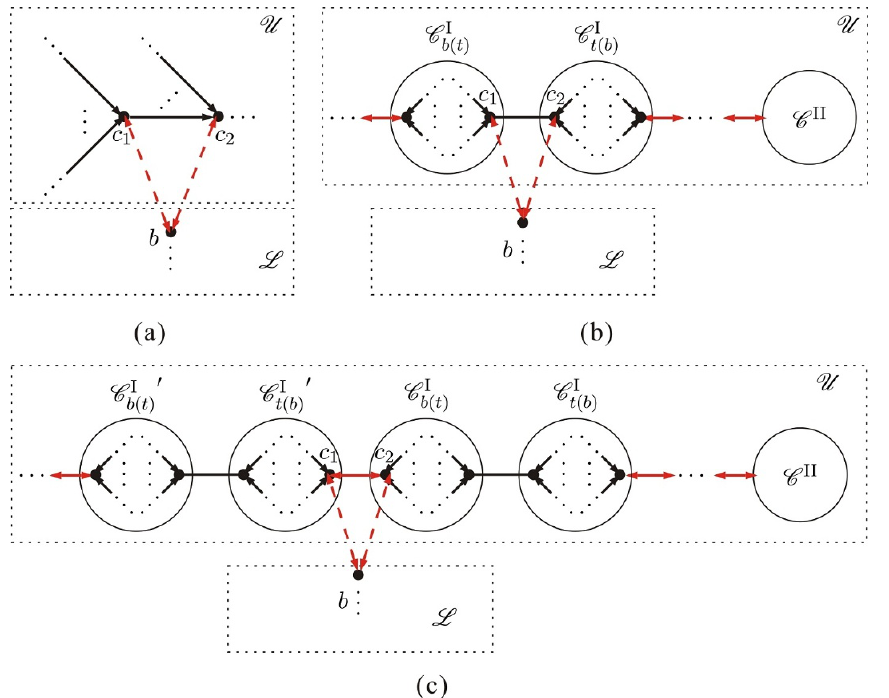
Figure 17 . For any given con(cid:12)guration of the (cid:12)nal upper and lower blocks U and L , the factors ( (cid:0) 1) N ( L )+ N ( U c )+ S ( U c )+1 (see eq. (6.7)) for graphs with a = c 1 and a = c 2 ( c 1 , c 2 are two adjacent nodes in the (cid:12)nal upper block) always have opposite signs. Particularly, the number N ( L ) is always independent of the choice of a . When we consider the number N ( U c ) + S ( U c ), there are three possible cases: (i) In (a), c 1 and c 2 are two end nodes of a type-3 line and they both belong to a same top or bottom side of some type-I component. The two graphs corresponding to a = c 1 and a = c 2 must have the same S ( U c ), but N ( U c ) = N ( U c ) + 1. (ii) In (b), c 1 and c 2 are two 1 2 end nodes of a type-1 line. Since a type-1 line does node carry arrow, we have N ( U c ) = N ( U c ). 1 2 The component C I is a spurious one for the graph with a = c 2 but not spurious for the graph with a = c 1 , thus S ( U c ) = S ( U c ) (cid:0) 1. (iii) Similarly, in (c), where c 1 and c 2 are two end nodes of a 1 2 type-3 line, we have N ( U c ) = N ( U c ) and S ( U c ) = S ( U c ) + 1 2 1 2